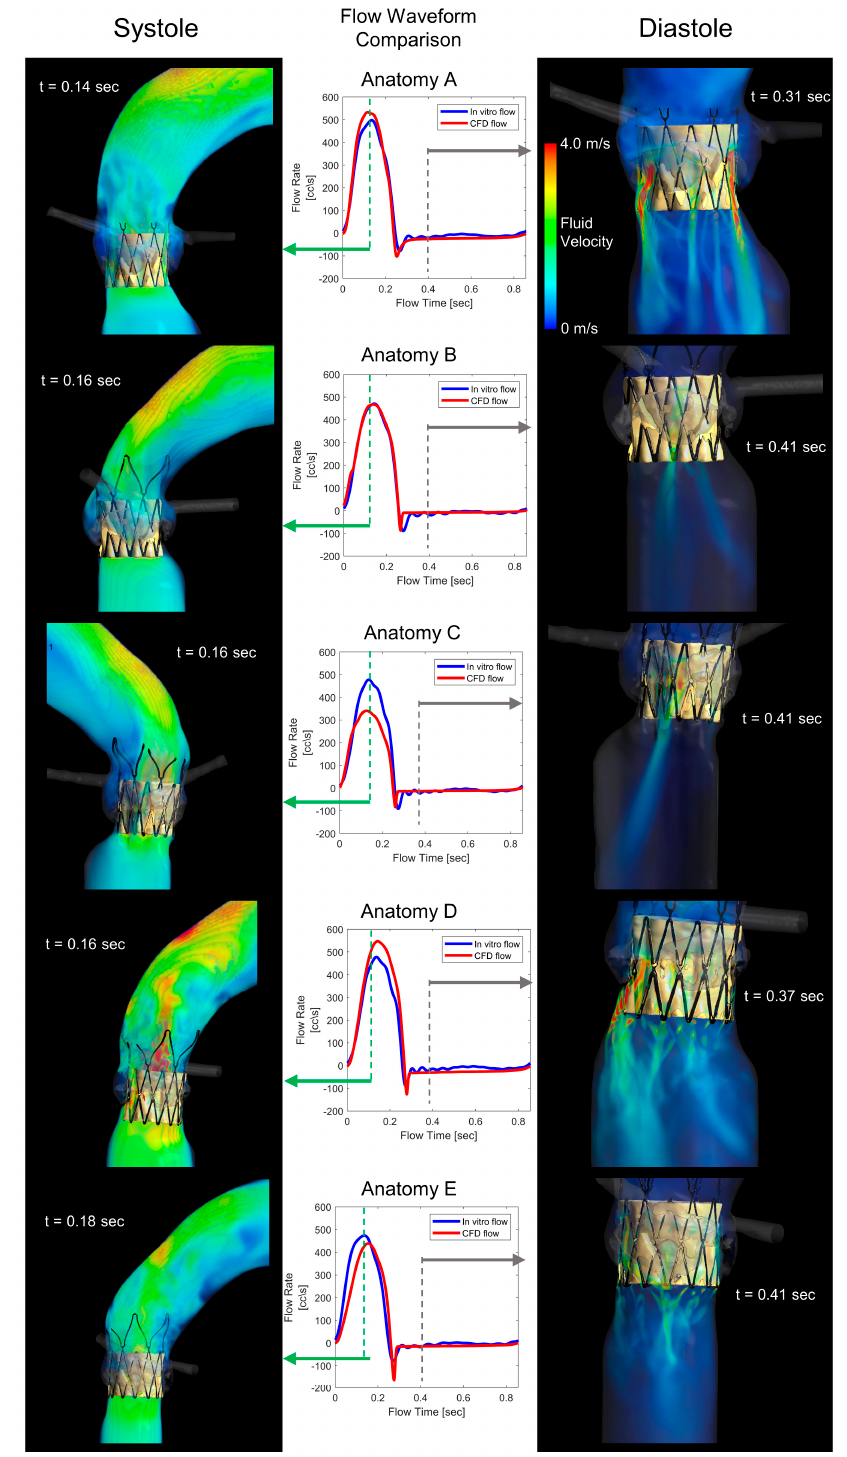
Figure 2. Flow pattern and waveform comparison—Volume of fluid (VOF) rendering of the fluid velocity of the CFD solution in systole ( left ) and diastole ( right ). Overlays of the flow waveform, comparing the in vitro and in silico solutions, with systole (green) and diastole (gray) timepoints labeled.